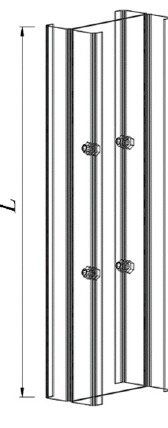
Figure 2. Parameters in the combined column.